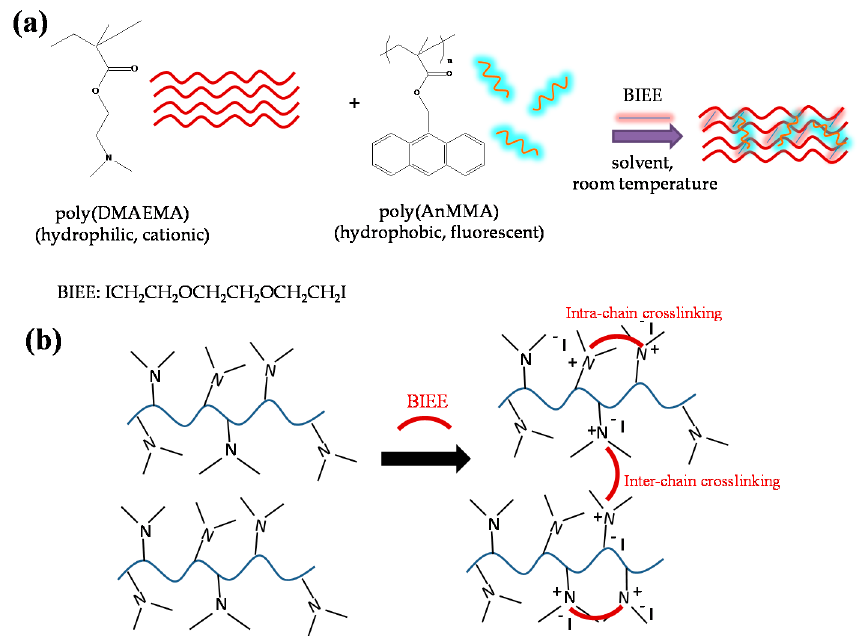
Figure 1. ( a ) Chemical structures of the linear poly(2-(dimethylamino)ethyl methacrylate) (pDMAEMA) and poly(9-anthrylmethyl methacrylate) (pAnMMA) homopolymers and of the 1,2-bis-(2-iodoethoxy)ethane (BIEE) crosslinking agent, and schematic of the one-step synthetic approach followed for the preparation of 3D luminescent semi-interpenetrating amphiphilic network (APN); ( b ) crosslinking reaction scheme presenting both, intra- and interchain crosslinking pathways that may occur between BIEE and –N(Me) 3 pendant moieties of the poly(DMAEMA) linear chains.